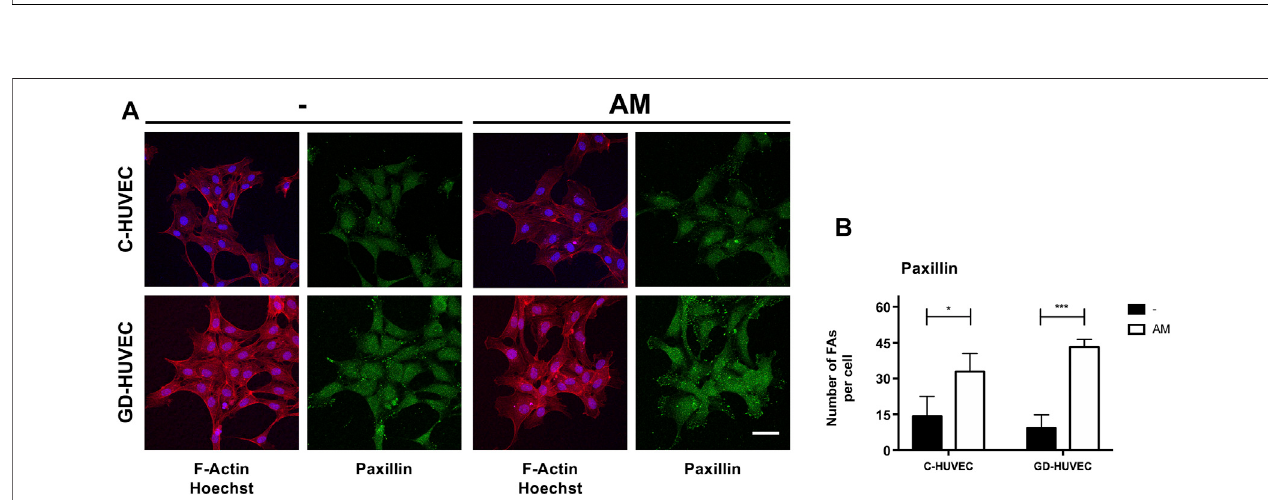
FIGURE 7 | AM induces an active remodeling of focal adhesions (FAs). (A) Sub-con fl uent C-HUVECs and GD-HUVECs were serum-starved cultured for 24 h in presence or absence of AM. Then, samples were immunostained with a speci fi c antibody against paxillin and co-stained with Hoechst-33258 and phalloidin to reveal nuclei and the actin cytoskeleton, respectively. All images were acquired using a confocal microscope and processed using ZEN software. These experiments were repeated at least three times. Representative images are shown. Bar represents 50 µm. (B) Focal adhesion (FA) quanti fi cation of Paxillin. All images were analyzed throughImageJsoftware.TheplotsrepresentthemeanofseveraltechnicalreplicatesofthreeC-HUVECandthreeGD-HUVECstrains( n =3).ThenumberofFAsasthe region of interests (ROIs) was selected and measured. * p < 0.05 and *** p < 0.001.